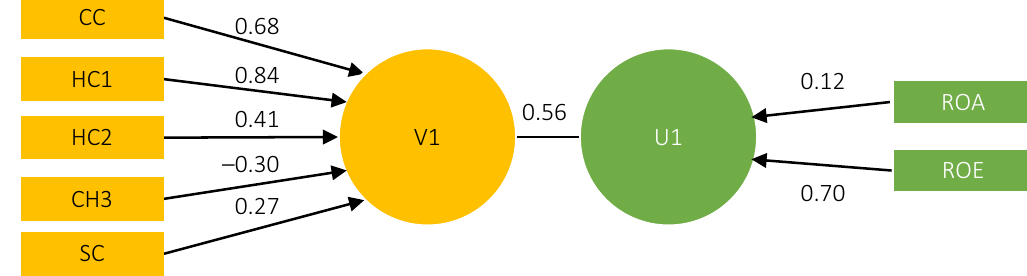
Figure 1. CCA between the first variate and two groups of variables